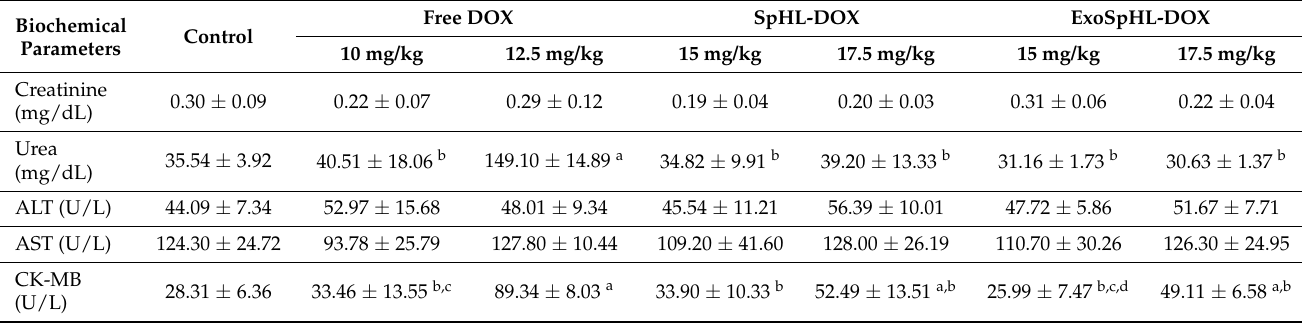
Table 2. Biochemical parameters for healthy Balb/c mice treated with different doses of free DOX, SpHL-DOX, or